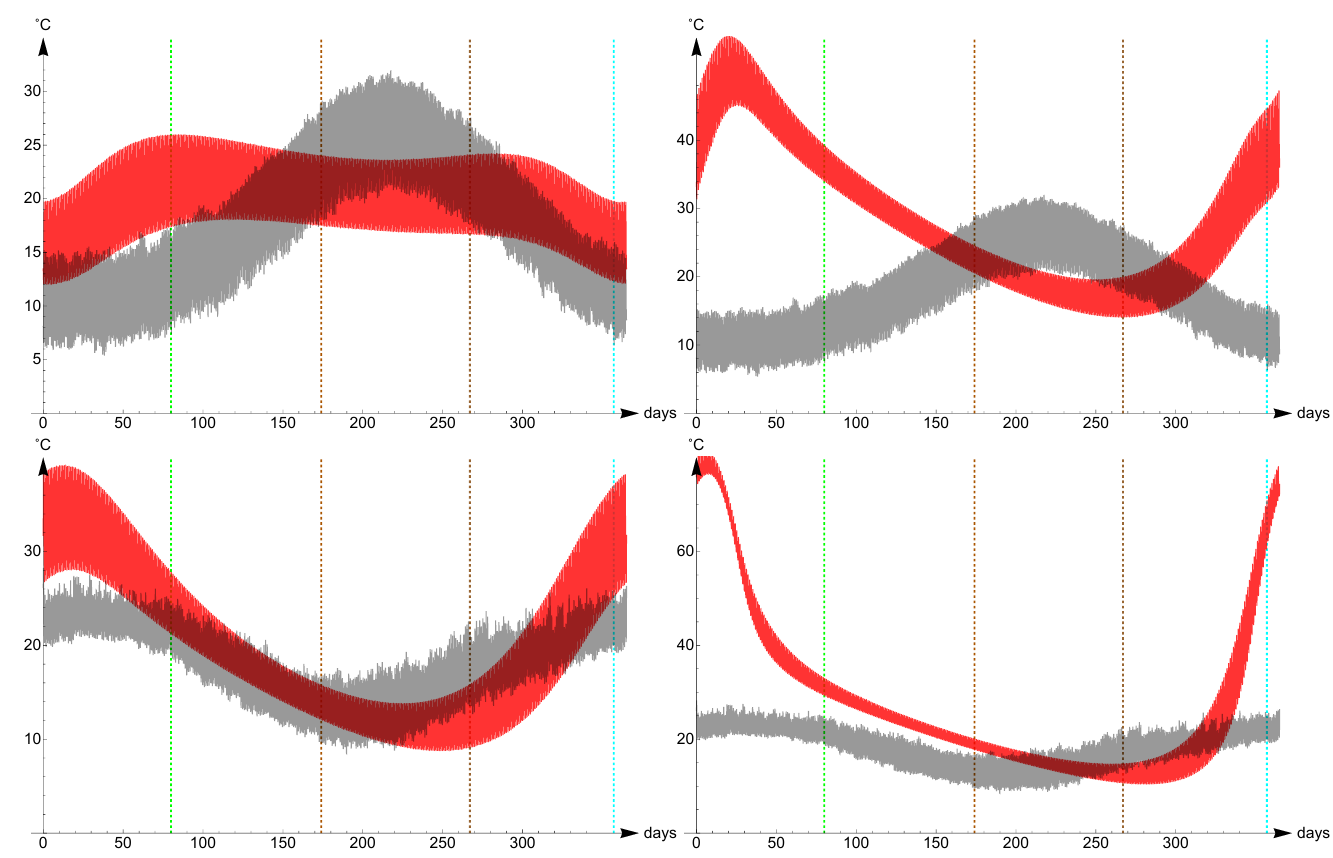
Figure 9. Temperatures in Catania ( above ) and in Sydney ( below ) if the eccentricity of Earth’s orbit was 0.2 ( left ) or 0.5 ( right ). In black the real temperatures, in red the ones obtained with the